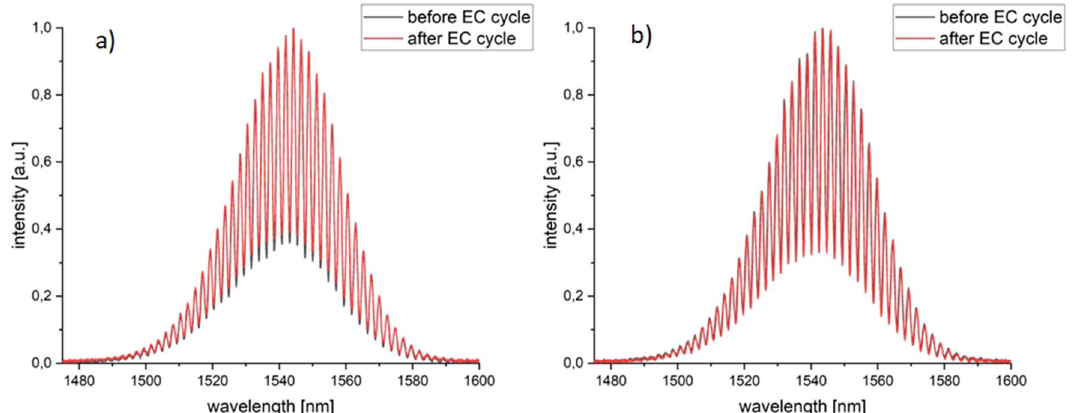
Figure 2. Optical spectra obtained before and after full electrochemical cycle. Spectra ( a ) and ( b ) show two out of five consecutive voltammetric cycles. Note the excellent overlap for the pairs, and the similarity of spectal pairs to each other across the longitudinal measurements, indicating that no significant perturbation appeared during measurements and the investigated sample (2.5 mM K 3 [Fe(CN) 6 ] in a 0.5 M Na 2 SO 4 ) was not damaged. The results indicate the successful performance of the BDD film in its dual role of a EC working electrode and an optically reflective To quantify this constancy further, the signal fringe visibility as well as spectral shift between spectra recorded before and after the EC cycle were calculated and are shown in Fig. 3. In interferometry, fringe visibility V describes the contrast of the obtained signal, and can be calculated using the maximal I max and minimal I min intensity values as follows: V = (I max − I min )/(I max + I min ). For the optimal cavity length in air, values approaching unity can be obtained for the BDD film 27 . In our experiment, with the cavity containing 2.5 mM K 3 [Fe(CN) 6 ] in a 0.5 M Na 2 SO 4 solution, a median value of V = 0.48 was obtained. This is due to the presence of the liquid inside the cavity and resulting absorption loss lowering the visibility value. From Fig. 3b. it can be noted that a small (< 0.5 nm) spectral shift occurs, likely stemming from the small instability of the light source. Figure 4 presents all spectra obtained for five repeated-measurement electrochemical cycles, divided into two groups: starting spectra registered before each EC cycle, and ending spectra registered after completing each EC cycle. As seen, no additional modulation occurs in optical signals for later measurements compred to the earlier ones, and the signal envelopes remain the same. These results confirm the repeatability of the measurements in the constructed opto-electrochemical system during the reversible redox reactions.